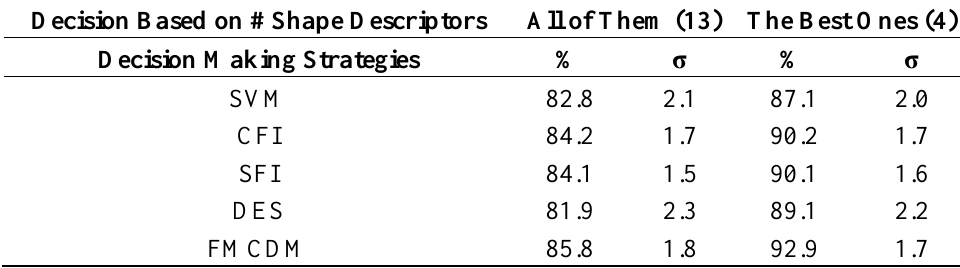
Table 2. Averaged classification accuracy and standard deviations obtained for the SVM, CFI, SFI, DES and FMCDM decision-making